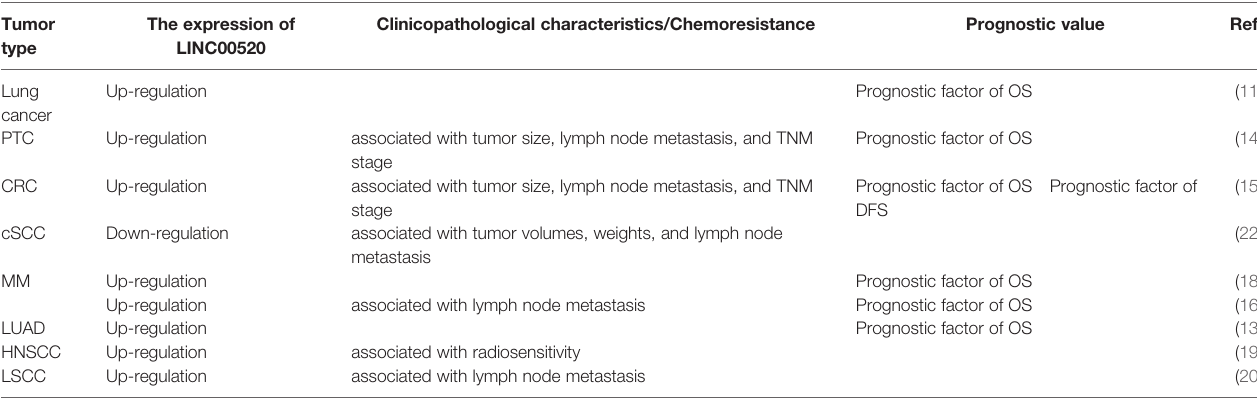
TABLE 2 | Clinic-pathological features or prognostic value of LINC00520 dysfunction.